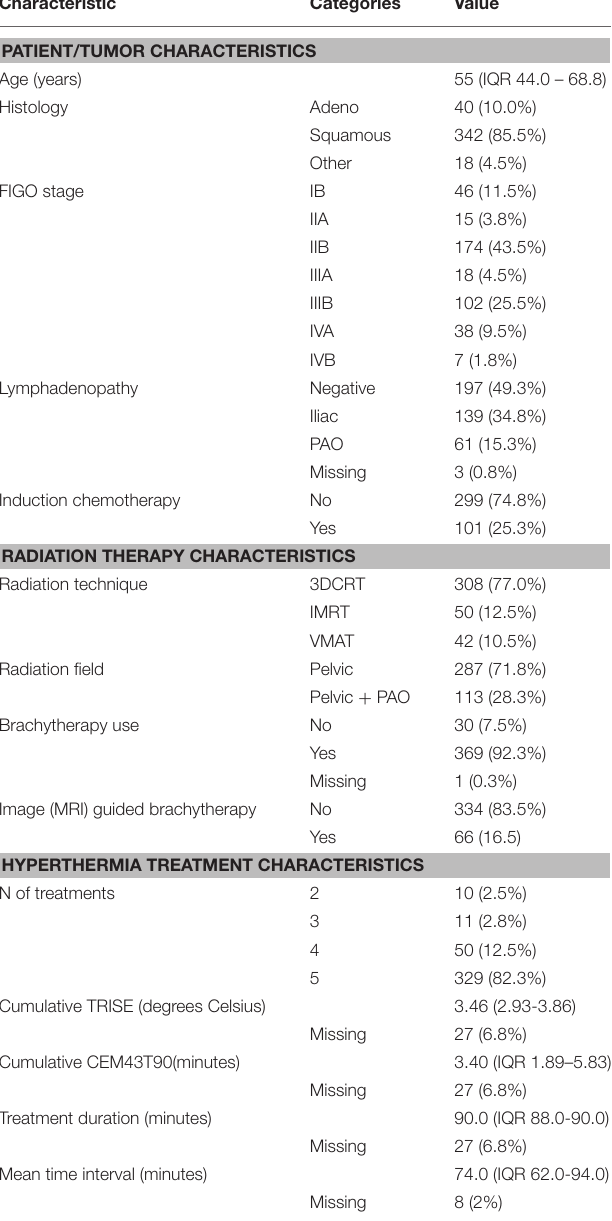
TABLE 1 | General characteristics of the